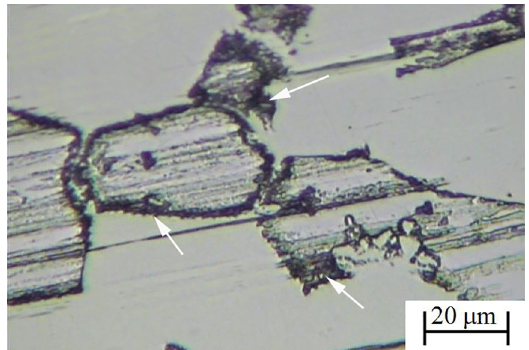
Figure 12. Microstructure obtained after portable DL-EPR test performed at room temperature in SD-B material aged at 800ºC for 45 minutes.